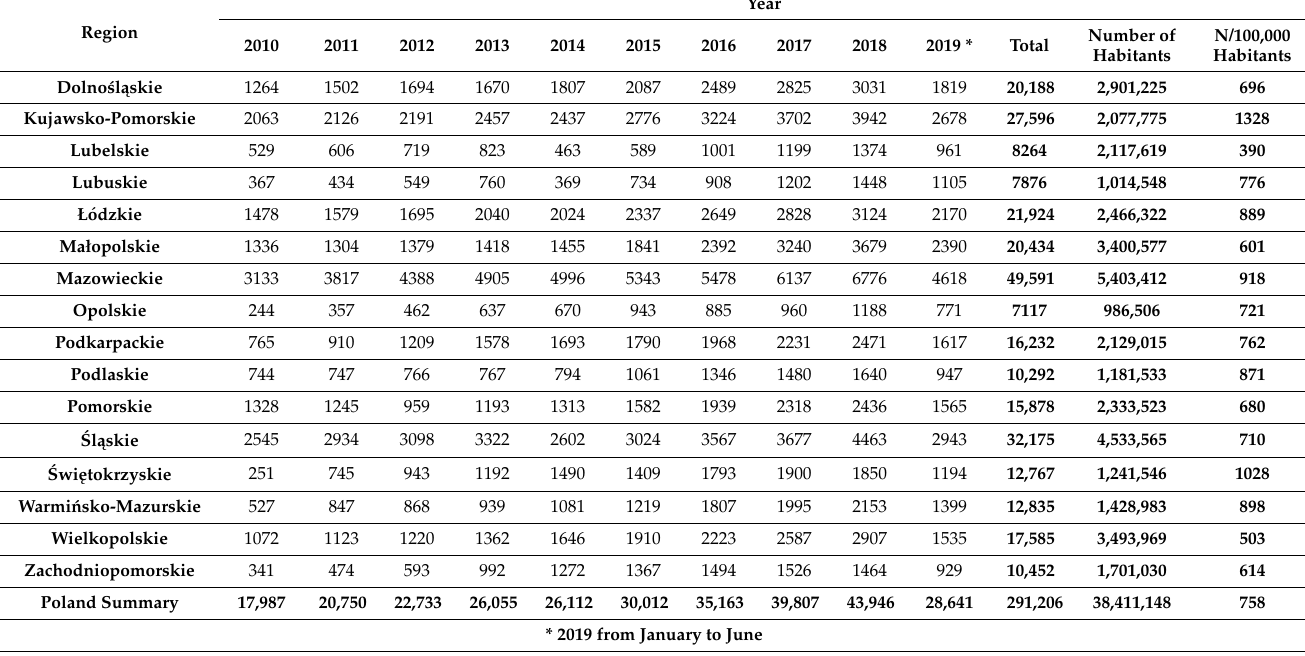
tants in each of the regions of Poland. The prevalence of OSAS diagnosis per 100,000 habi- tants is highest in the regions Kujawsko-Pomorskie ( N = 1328), ´Swi˛etokrzyskie ( N = 1028), and Mazowieckie ( N = 918). A PSG was performed the most frequently in the regions ´Swi˛etokrzyskie ( N = 910), Lubuskie ( N = 803), and Opolskie ( N = 803). PAP therapy was the most common in the regions Kujawsko-Pomorskie ( N = 265), ´Swi˛etokrzyskie ( N = 257), and Lubuskie ( N = 244). Table 1. Number of patients with a diagnosis of obstructive sleep apnea syndrome (OSAS), the number of polysomnogra- phies, and the number of reimbursements of positive airway pressure (PAP) treatment in all regions of Poland from 2010 to 2019. The bold in number is summary of all data